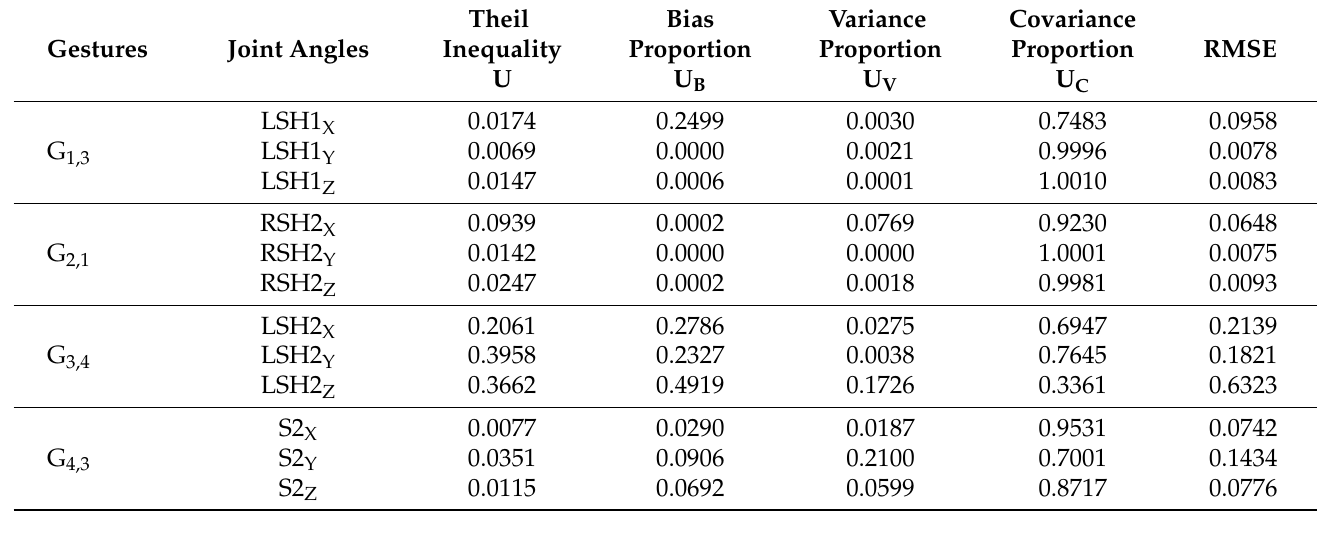
Table 12. Forecasting performance of one gesture for each gesture vocabulary.